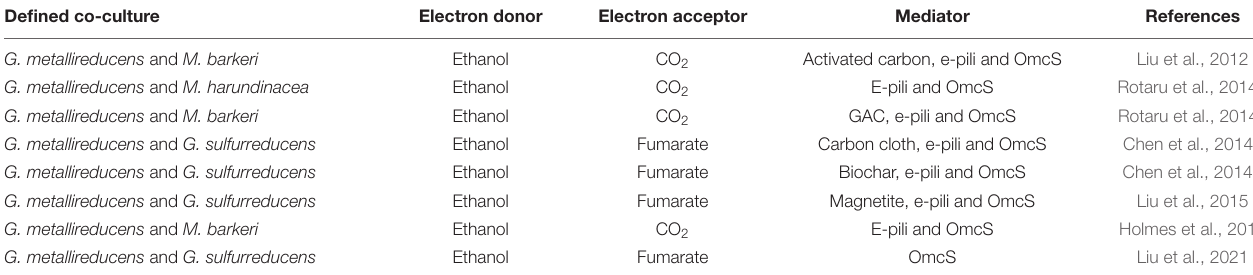
TABLE 1 | Summary of studies on direct interspecies electron transfer (DIET) in defined